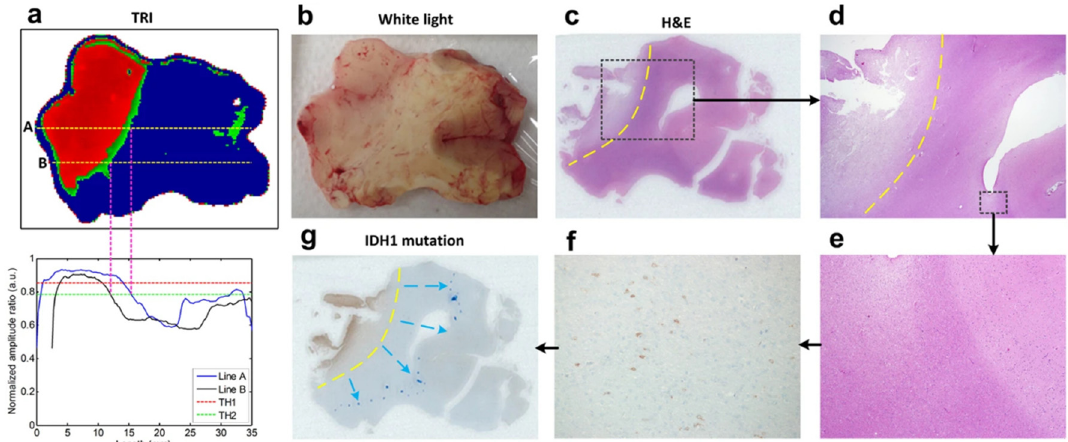
Figure 21. Delineation of the tumor margin with TRI. ( a ) TRI image of glioma, ( b ) White light image of the specimen, ( c ) Tumor margins (yellow dashed line) determined by H&E stained image. ( d ) Magnified H&E image (x12.5) of the black dashed box region in ( c ). ( e ) A further magnified image (x40) of black dashed box region in ( d ). ( f ) A magnified immunohistochemistry image (x400) of some region in ( e ). ( g ) Based on the image stained with the IDH1 mutation, the tumor margins (blue dots) are redefined. Reprinted from [158].